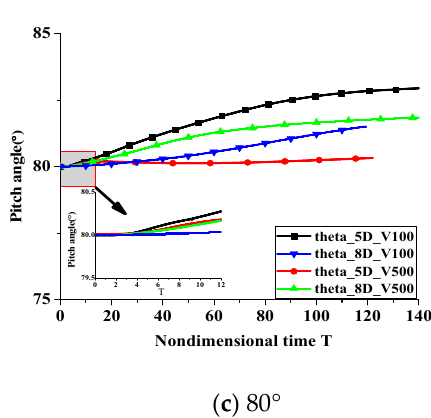
Figure 8. Time histories of pitch angles at different entry angles: ( a ) 10°, (b) 45°, ( c ) 80°.